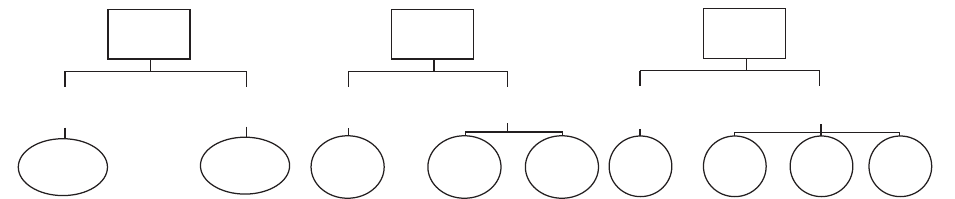
Figure 2: Example of Hypertexto structures, in which students select, relate, and transmit the